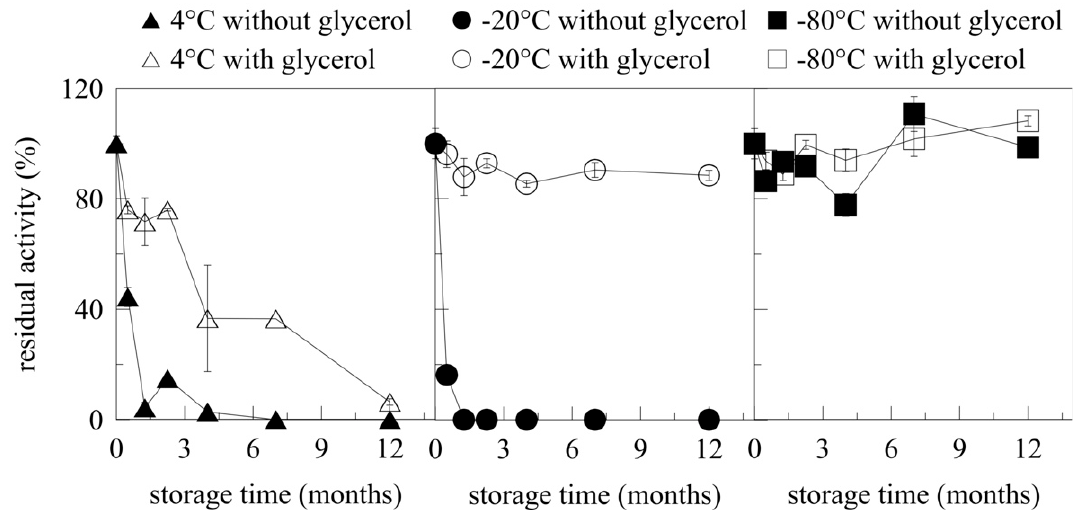
Figure 6. Long-term storage of recombinant myrosinase. Residual activity of recombinant At TGG1 myrosinase stored in the form of culture supernatant with and without glycerol at 4, − 20 and − 80 °C.